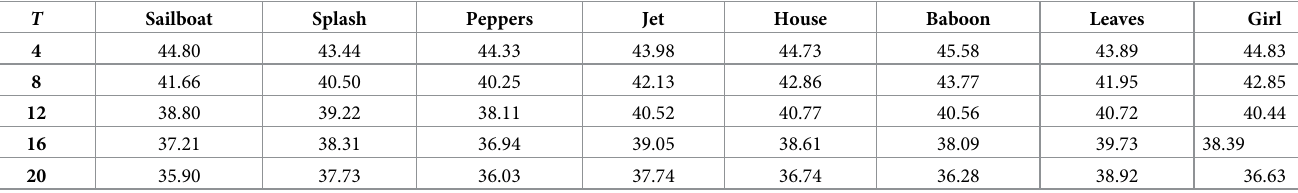
Table 4. PSNR comparisons of a variety of